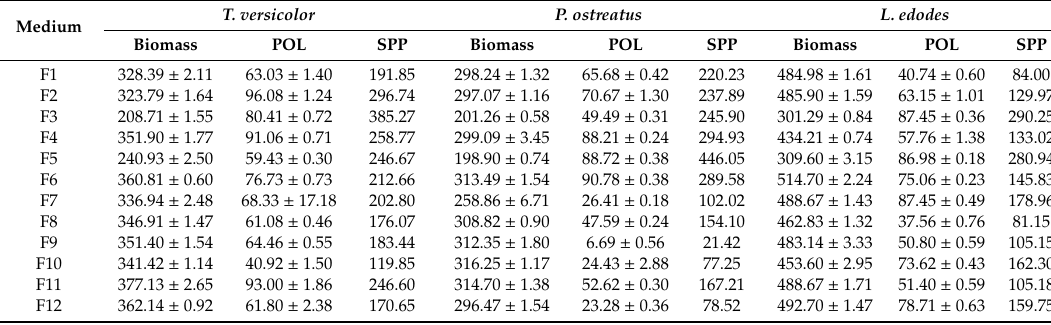
Table 2. Fungal biomass (mg / g dry solid) and polysaccharide (mg / g dry solid) concentrations and specific polysaccharide production ( µ g polysaccharide / g dry mycelium) by T. versicolor , P. ostreatus and